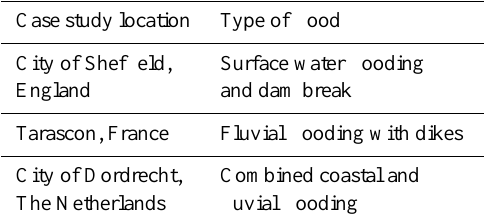
Table 3. Flood hazards for the different case study locations.